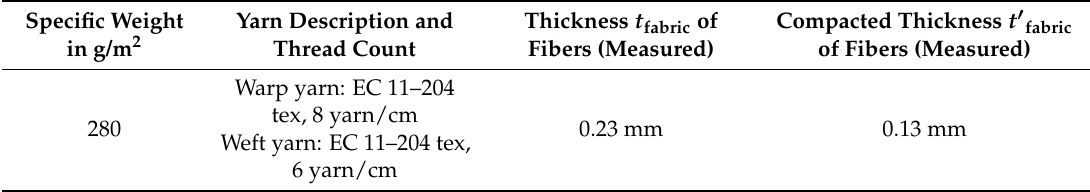
Table 2. Parameters of plain woven fibers.